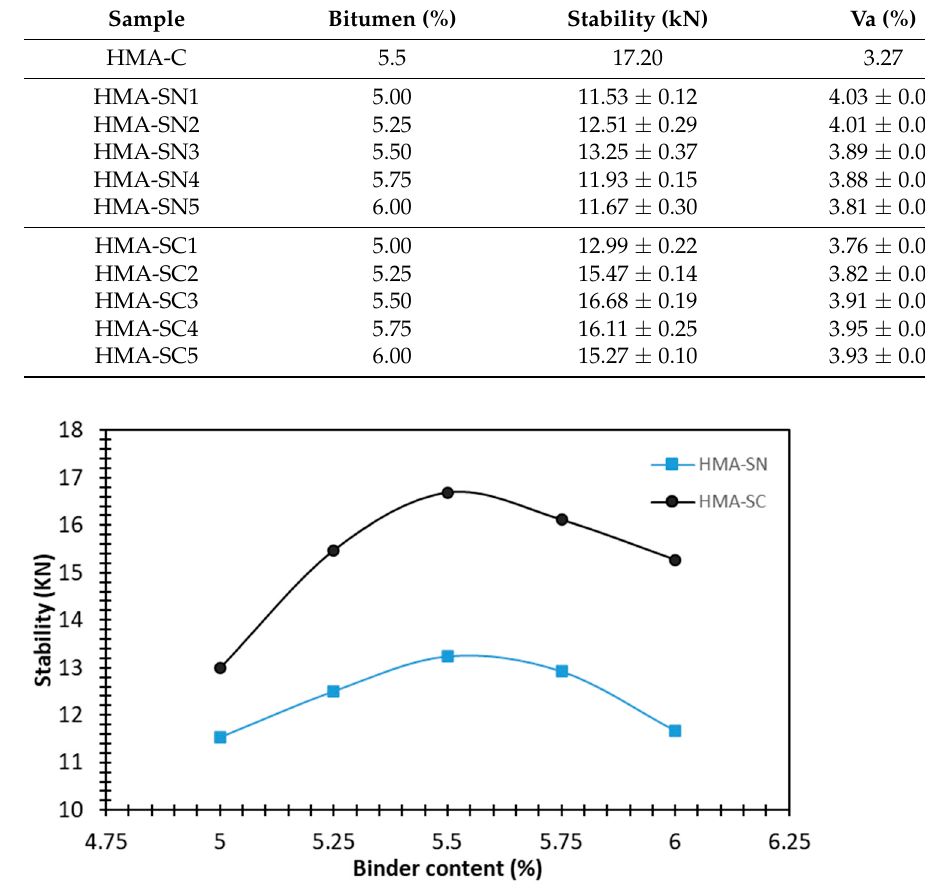
Figure 4. Marshall stability for the HMA samples.